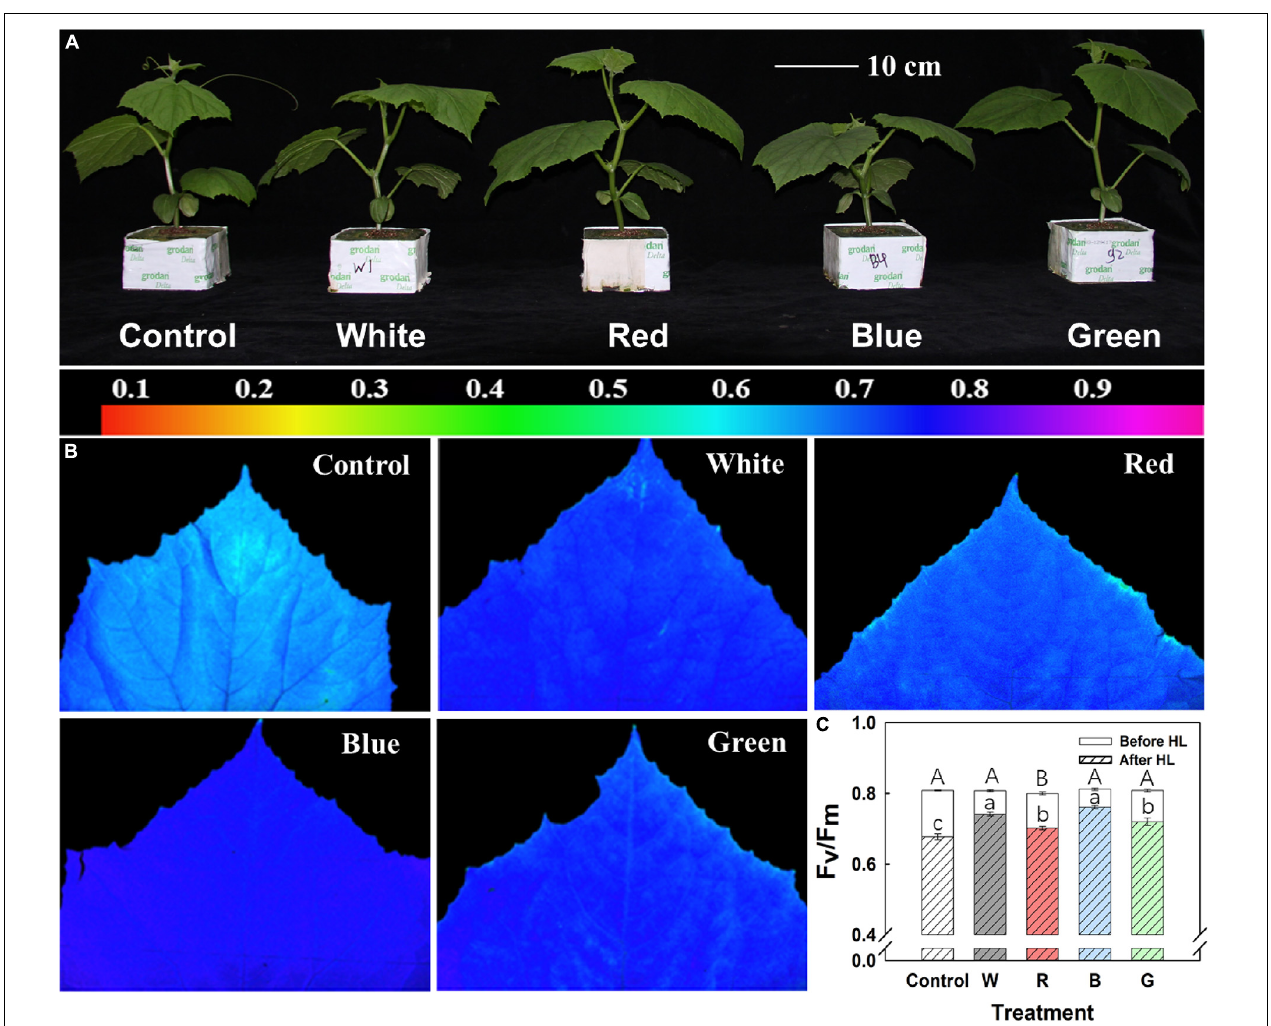
FIGURE 3 | Plant morphology and photoinhibition. (A) Representative images showing cucumber plants grown for 10 days under different supplemental light spectra: Control (C, shade solar light), white (W), red (R), blue (B), and green (G). (B) Representative false color images of maximum quantum efficiency of photosystem II photochemistry (F v /F m ) distribution after high light (HL, 30 min, 1,100 µ mol m − 2 s − 1 ) treatment, including color scale. (C) Averaged F v /F m before and after HL treatment. Mean values ± SEM of four biological replicates in one experimental batch are shown ( n = 4). Different letters in panel (C) indicate a significant treatment effect on F v /F m before (capital letter) and after (lowercase letter) HL, respectively ( p <